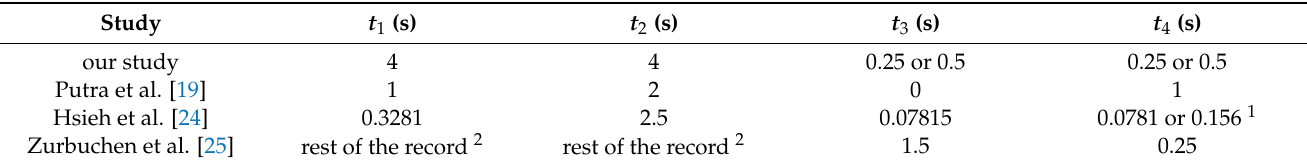
Table 5. Duration of data segmentation windows used in previous research compared to the ranges recommended in this